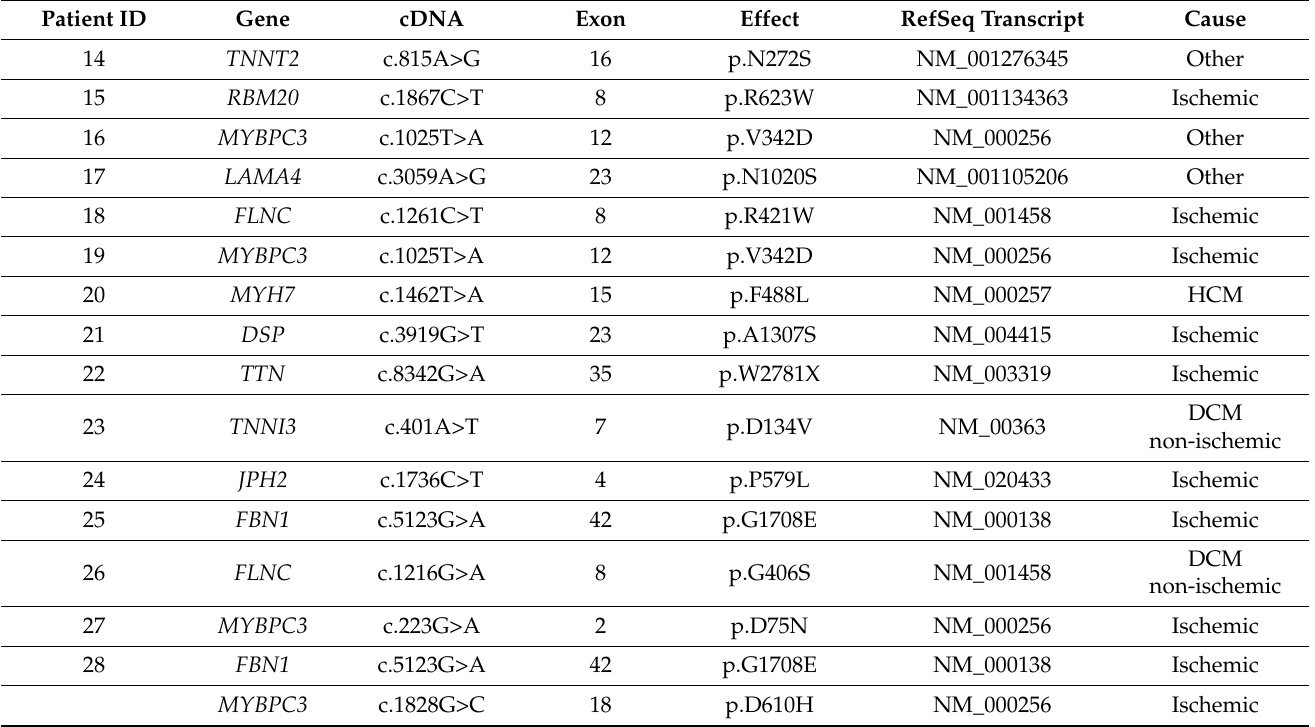
Table 3. Variants of uncertain significance